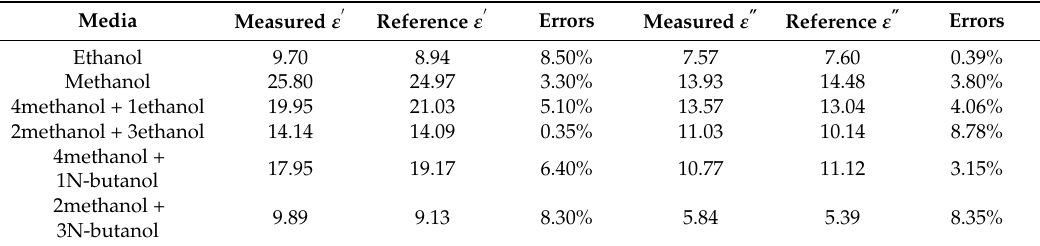
Table 2. Comparison of measured and reference dielectric properties of several samples at room